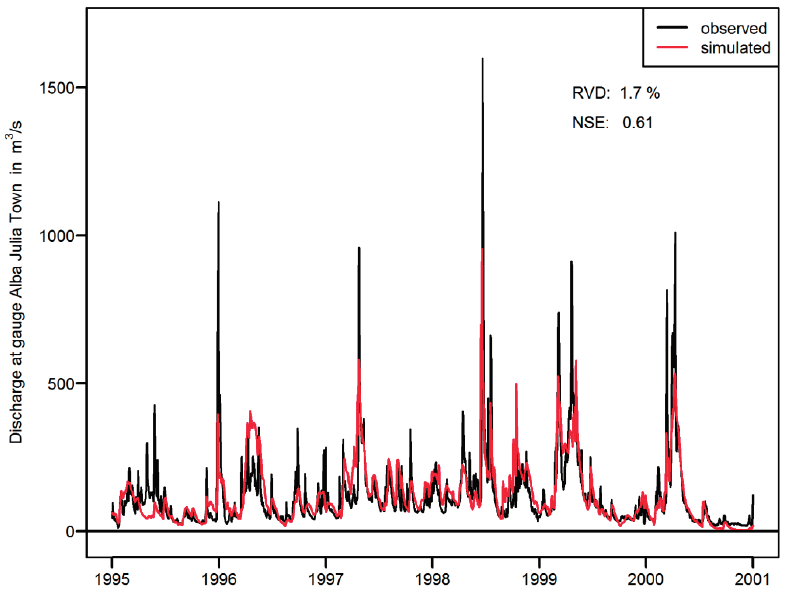
Figure 4. Validation of Mures River model until Alba Julia gauge, over period from 1996 to